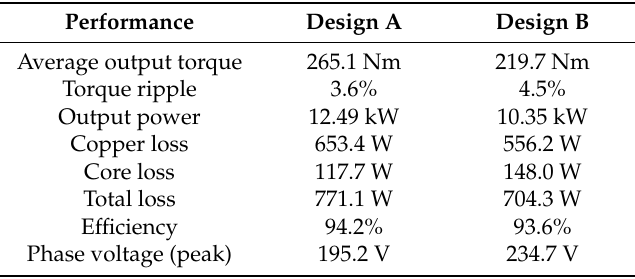
Table 6. Simulation results at rated point.